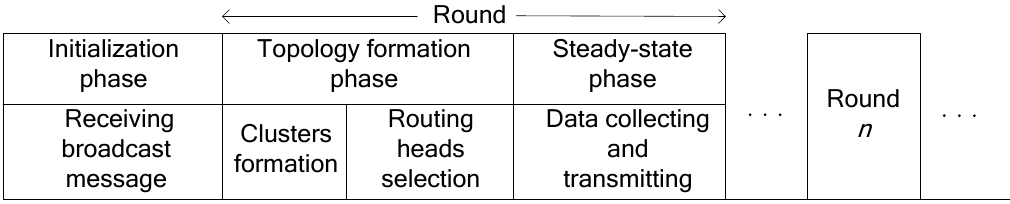
Figure 3. Time line denoting the procedure of MENC.